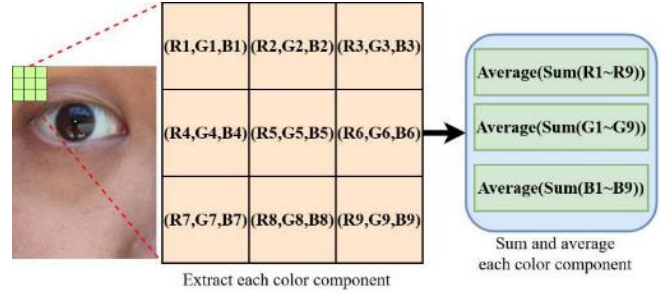
Figure 6. Grayscale operation on one of the captured images.